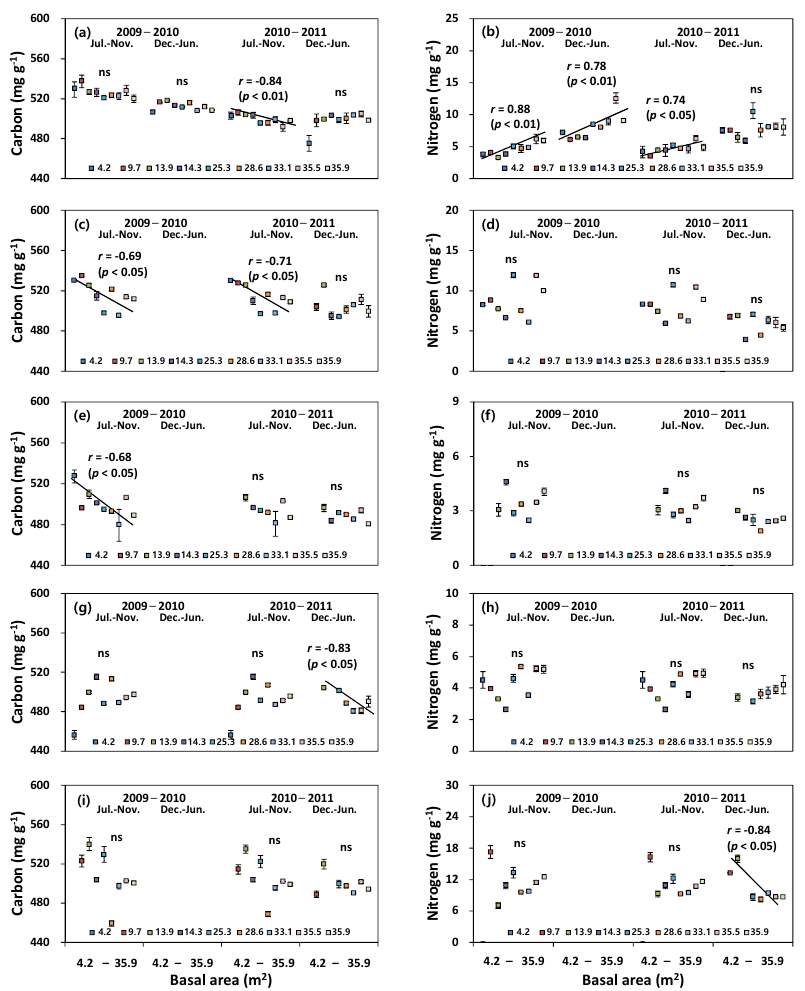
Figure 2. Correlation between carbon and nitrogen concentration ( n = 3) in litterfall components [( a , b ) needle, ( c , d ) branches, ( e , f ) bark, ( g , h ) cones and flowers, ( i , j ) miscellaneous] and basal area in pine wilt disease disturbed stands. Vertical bars represent standard error. ns: non-significance.